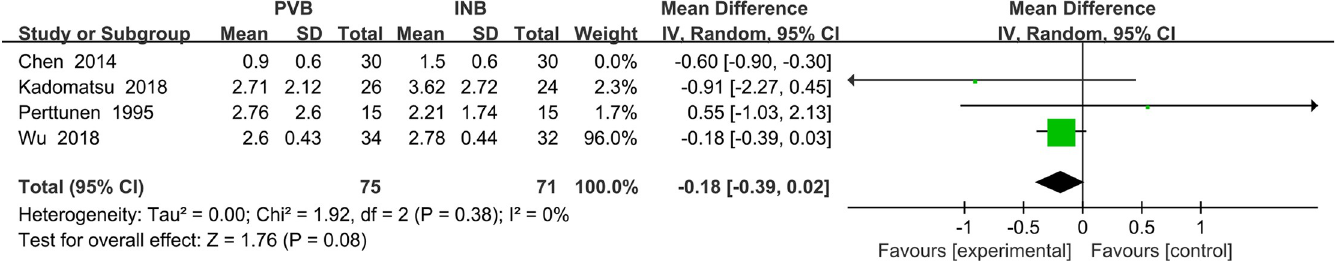
Fig 11. Forest plot of comparison: PVB VS INB. Outcome after exclusion of the study Chen (2014): VAS at rest at the first 24 h.